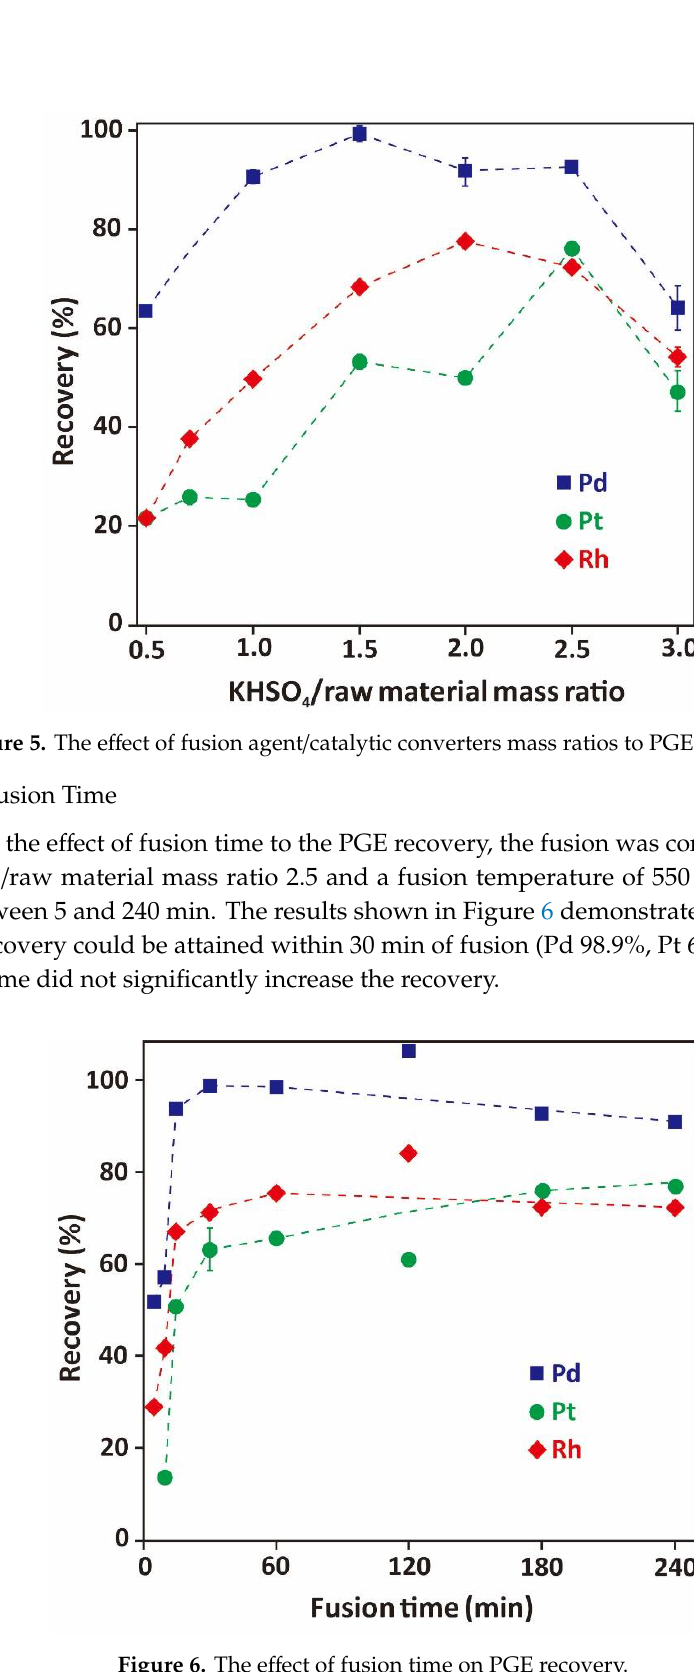
Figure 6. The e ff ect of fusion time on PGE Figure 6. The effect of fusion time on PGE recovery. Figure 6. The effect of fusion time on PGE recovery.